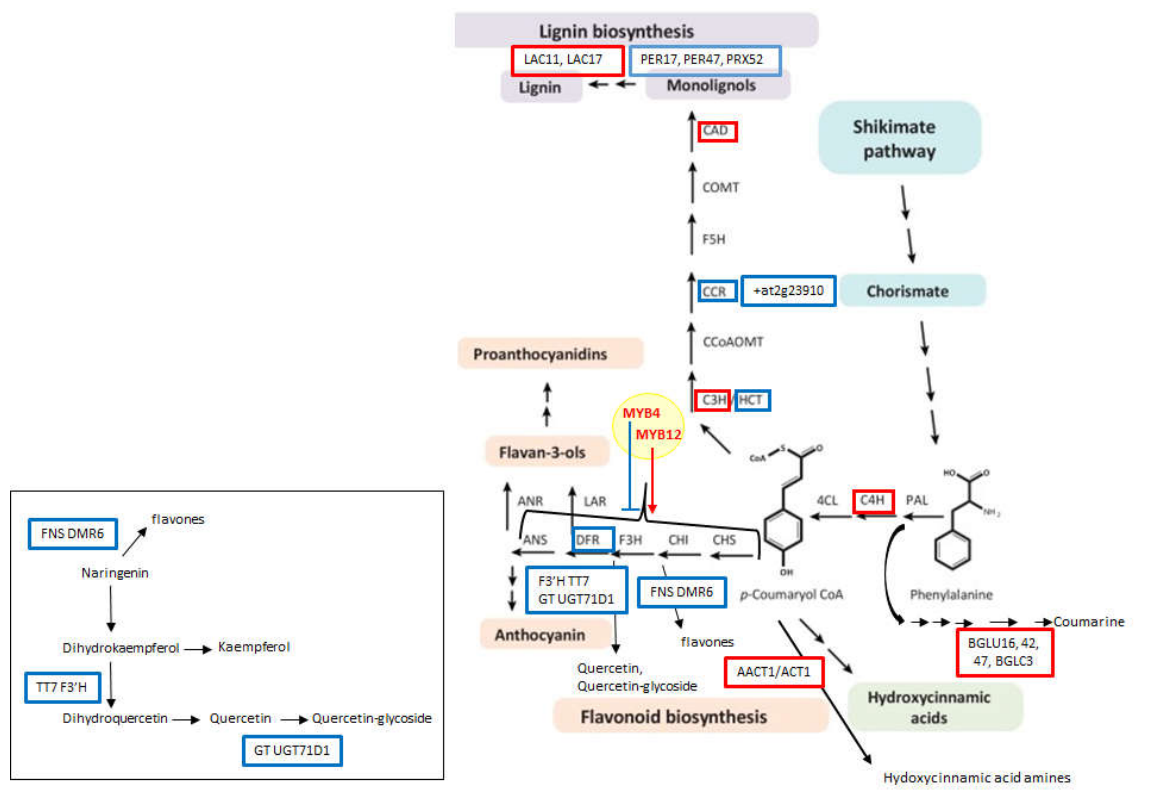
Figure 6: Genes framed in red are induced, genes frames in blue are repressed. Framed in black, the detail of genes involved in flavonoids production and found in this interaction. Abbreviations: 4CL, 4- coumarate-CoA ligase; AACT, anthocyanin 5-aromatic acyltransferase; ANR, anthocyanidin reductase; ANS, anthocyanin synthase; BGLC or BGLU, β-glucosidases; C3H, coumarate 3-hydroxylase; C4H, cinnamate 4-hydroxylase; CAD, cinnamyl alcohol dehydrogenase; CCoAOMT, caffeoyl-CoA O- methyltransferase; CCR, cinnamoyl-CoA reductase; CHI, chalcone isomerase; CHS, chalcone synthase; COMT, caffeic acid 3-O-methyltransferase; CPK, calcium-dependent protein kinase ; DFR, dihydroflavonol reductase; DMR6, downy mildiou resistant 6; F3H, flavanone 3-hydroxylase; F3’H flavonoid 3’- hydroxylase; FLS, flavonol synthase; FNS, flavone synthase; GGT1, gamma-glutamyl transpeptidase 1; GT, glucosyl transferase; HCT, hydroxycinnamoyl-CoA shikimate/quinate hydroxycinnamoyl transferase; LAC, laccase; LAR, leucoanthocyanidin reductase; OMT1, O-methyltransferase 1; PAL, phenylalanine ammonia- lyase; PER or PRX, peroxidase; TT7, transparent testa 7; UGFT, UDP-glucose flavonoid-3-O- glucosyltransferase; UGT71D1, UDP-glycosyltransferase